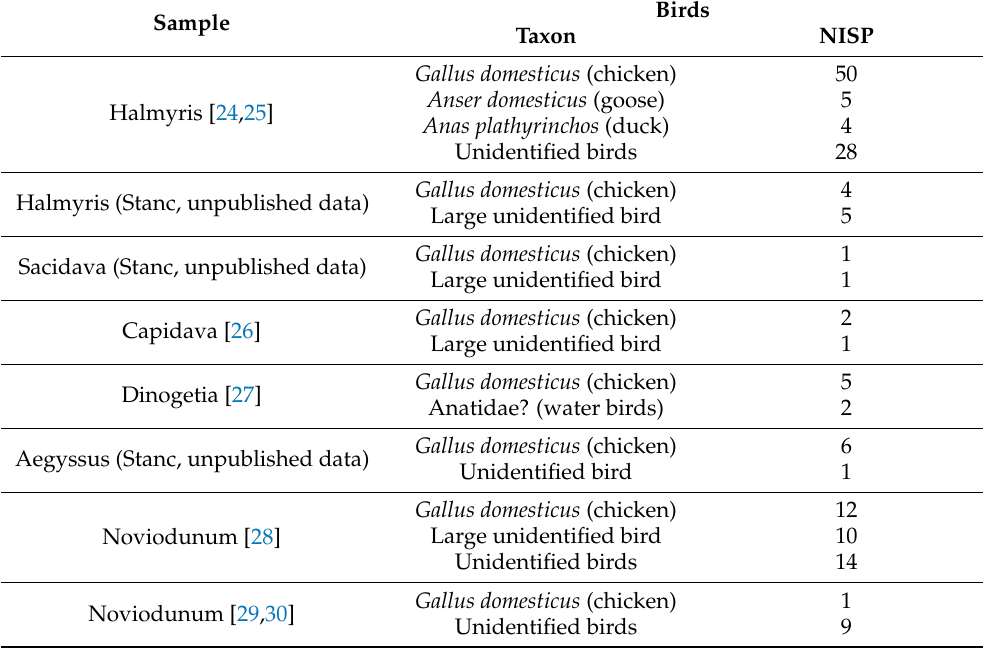
Table 3. Identified birds in Lower Danubian archaeological